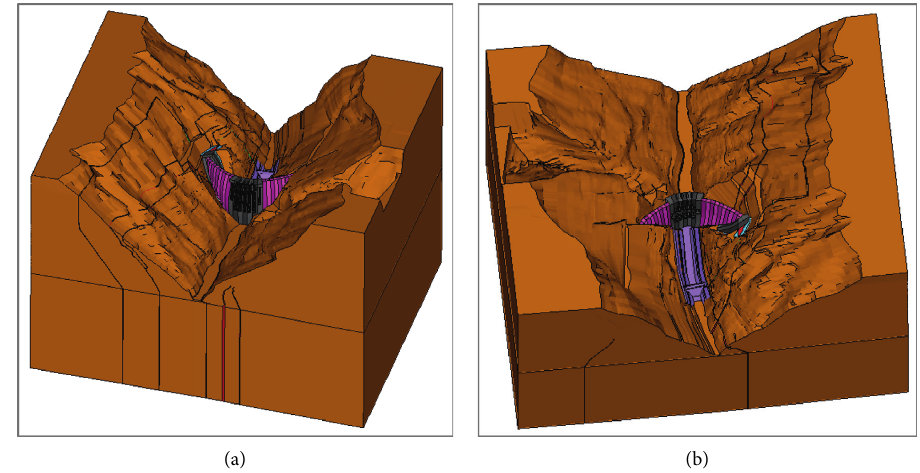
Figure 7: Finite element model of the Jinping-I arch dam: (a) upstream side view and (b) downstream side